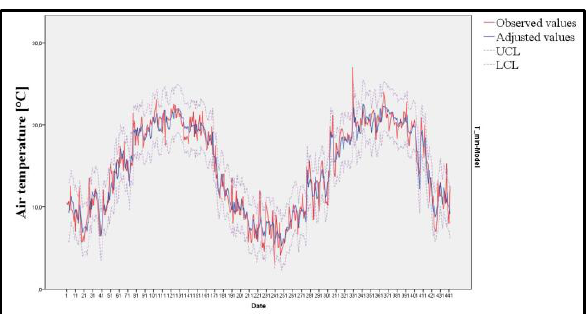
Figure 8. Time series curve of Tmin from 2011 to 2012 (UCL: Upper Control Limit; LCL: Lower Control